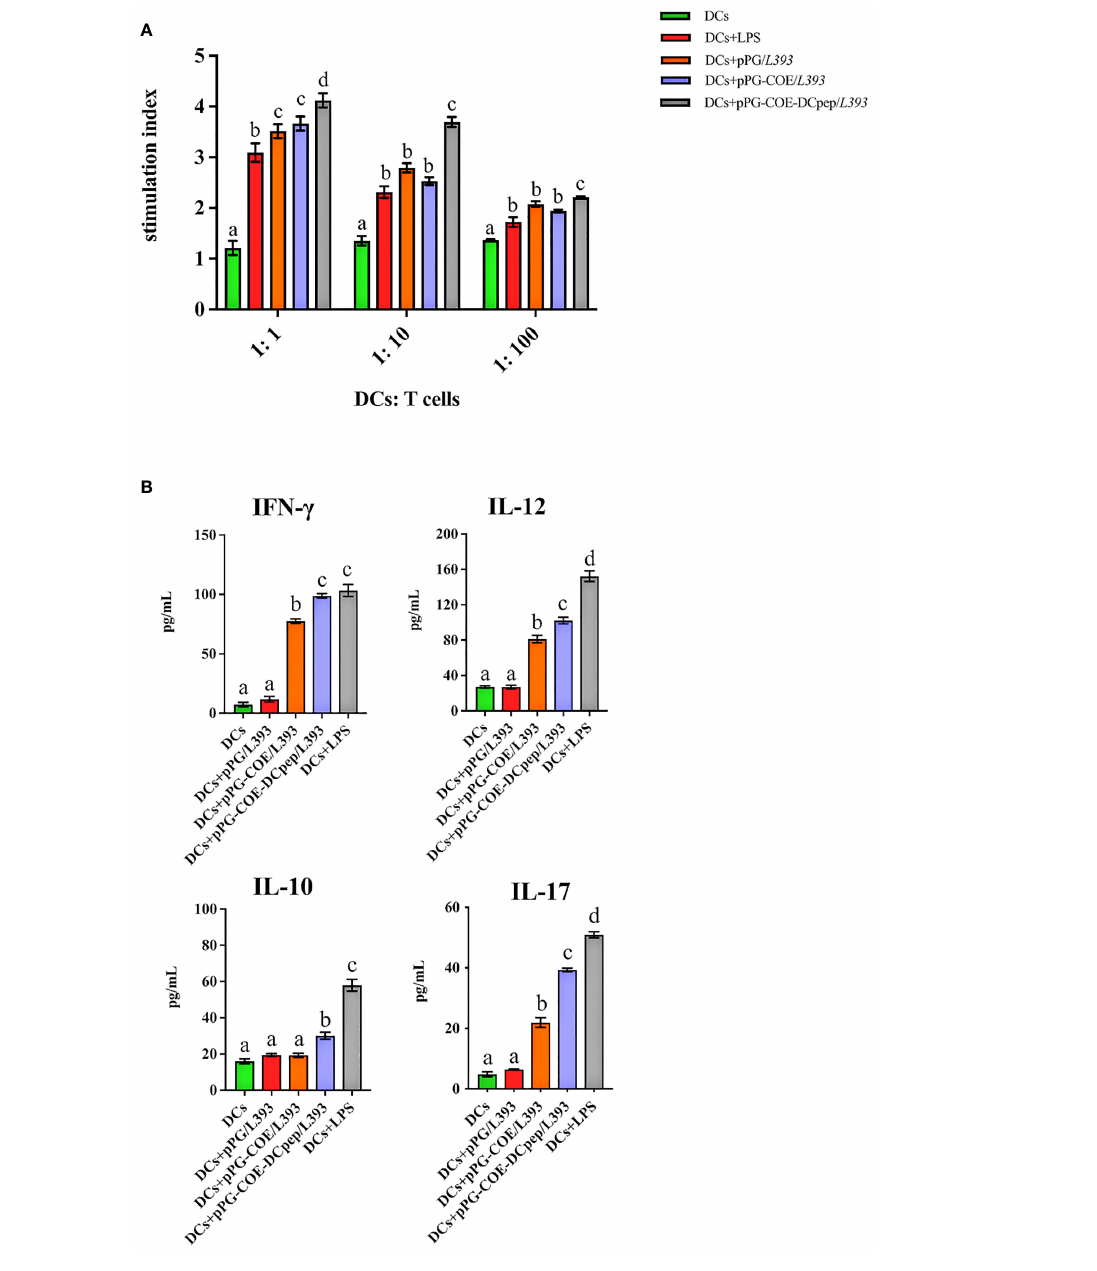
FIGURE 6 Analysis of Mo-DCs treated with pPG/ L393 , pPG-COE/ L393 , pPG-COE-DCpep/ L393 , and LPS skew T cells toward different effector T cell pro fi les. (A) Mo-DCs treated with recombinant Lactobacillus and LPS stimulate the proliferation of T lymphocytes in mixed lymphocyte reaction (MLR). Responder cells were added at ratios of 1:1, 1:10, or 1:100 and co-cultured with the stimulated cells for 72 h. Proliferation is expressed as the Stimulation Index (SI) calculated using the formula: SI = (OD sample − OD stimulator cells only ) / (OD responder cells only − OD blank control ). All experiments were performed at minimum in triplicate. Data are presented as mean ± SEM (n = 6 per group). (B) MoDCs were stimulated with recombinant Lactobacillus and LPS for 12 h, and then co-cultured with allogenic T cells at a ratio of 1:10. After 72 h, culture supernatants were collected and analyzed for cytokines by ELISA. Different letters (a vs. b, a vs. c, b vs. c) indicate signi fi cant differences (p < 0.01) at the same time